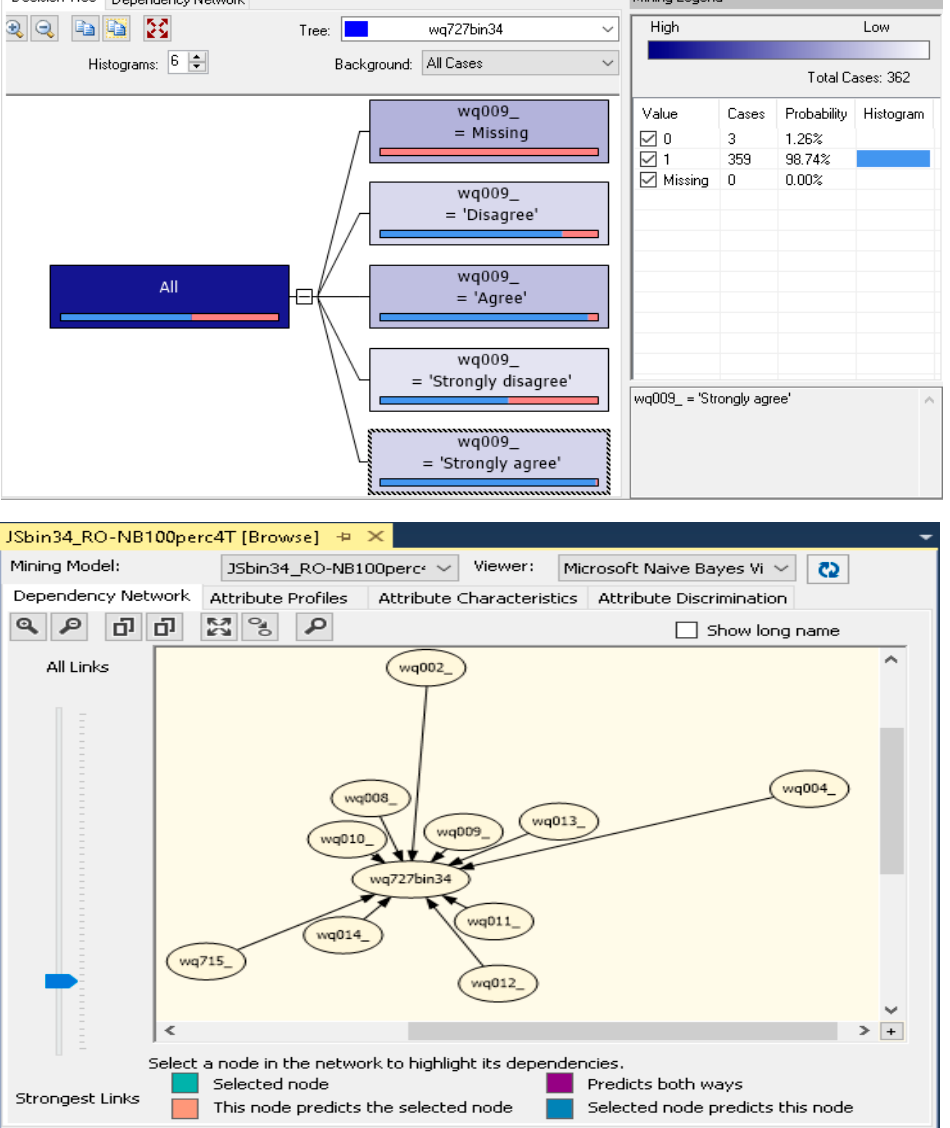
Figure 1. The most important predictor of job satisfaction (Decision Trees—first split) and top 10 strongest ones (naive Bayes—the shorter the arrow, the stronger the relation according to the vertical slider), all identified in the first round DM in SSAS, when analysing job satisfaction.